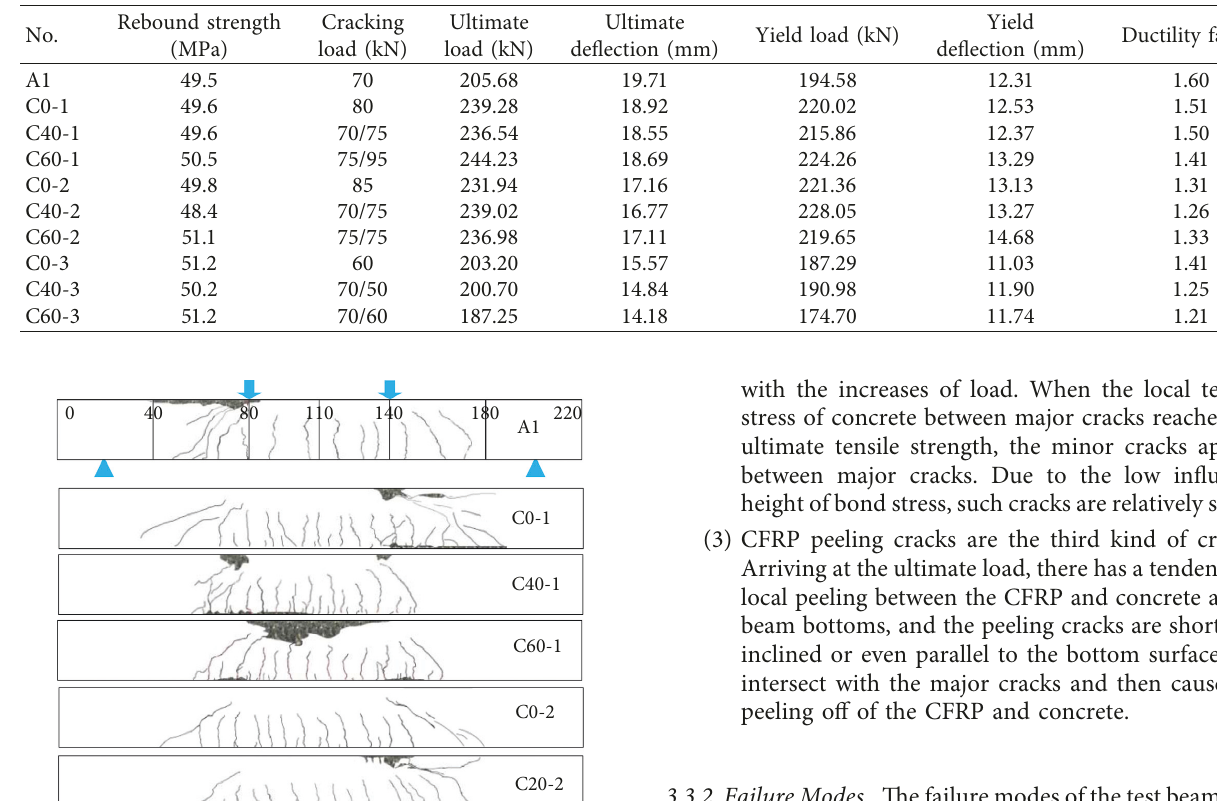
Table 5: Summary of the results.